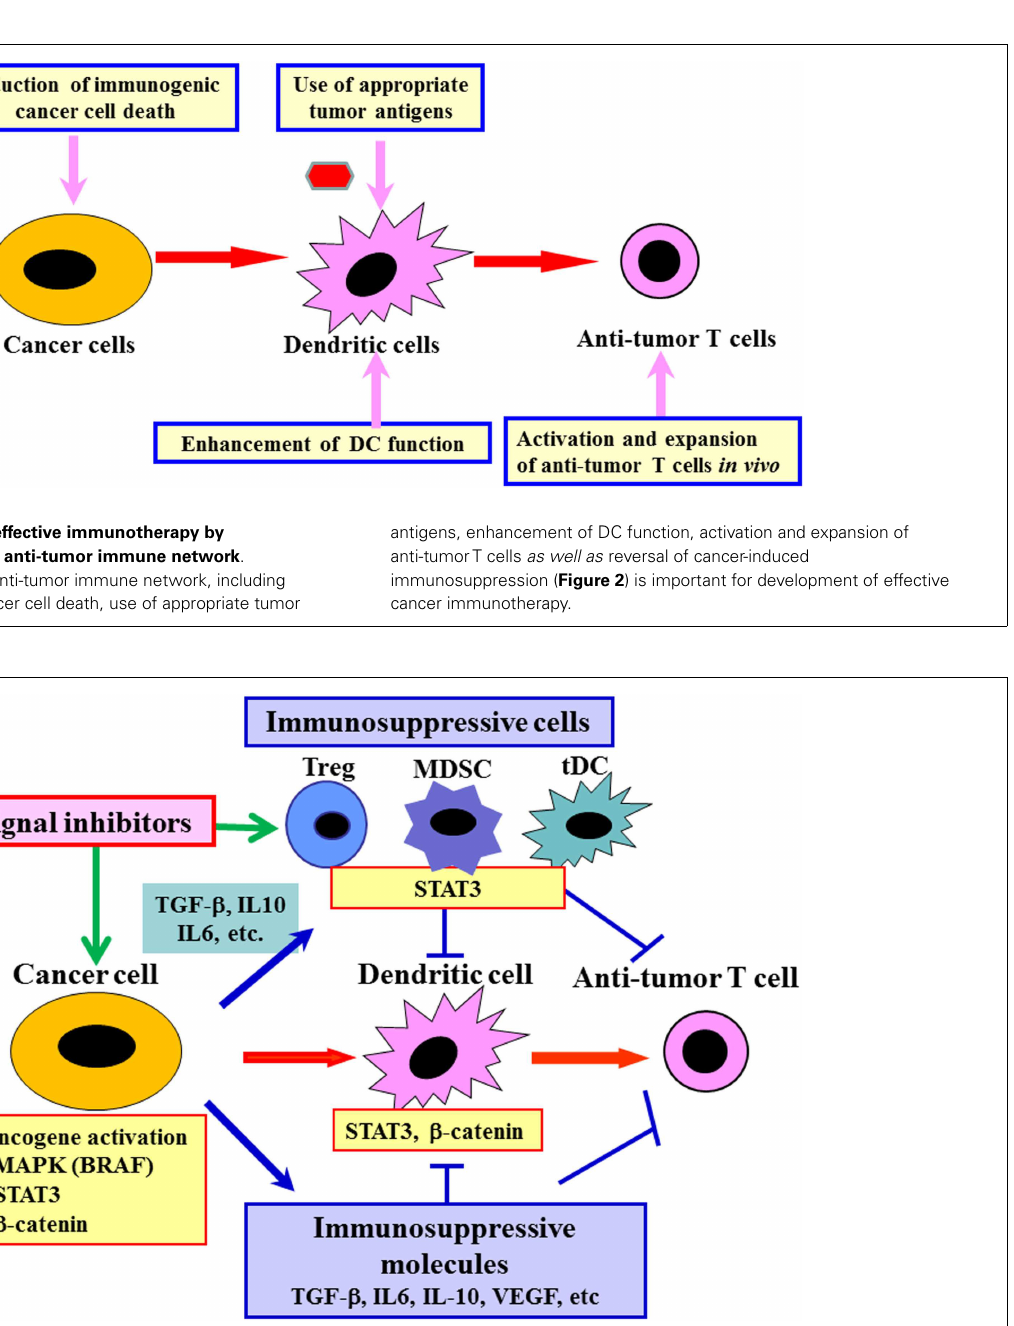
signaling activation, leading to impaired anti-tumor immune responses. Molecular targeted drugs including various signal inhibitors may be useful for augmentation of anti-tumor immune responses by acting on both cancer cells and various immune cells such as DC, MDSC, andTreg.